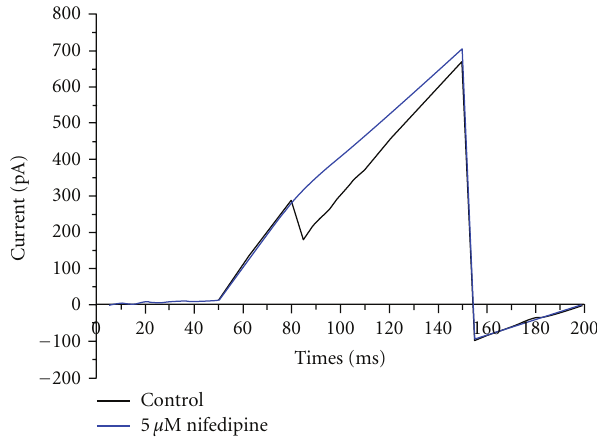
Figure 2: Representative traces show that depolarizing voltage steps elicited inward current in IECs and the inward current was inhibited by nifedipine (5 μ